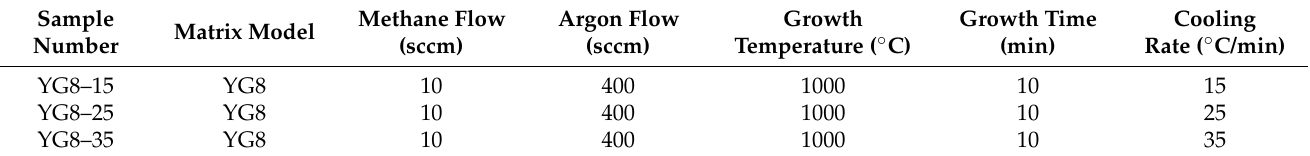
Table 1. The process parameters based on cooling rate.